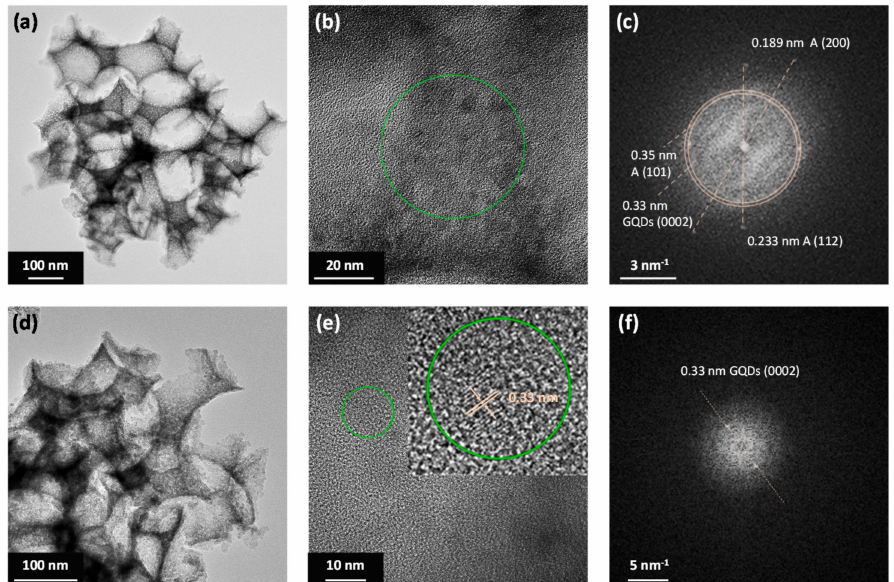
Figure 4. ( a , b , d , e ) TEM images of the QGD-PC261 film at di ff erent magnifications. ( c , f ) show the fast Fourier-transform (FFT) patterns of the areas indicated by circles in the high-resolution TEM images of ( b , e ),